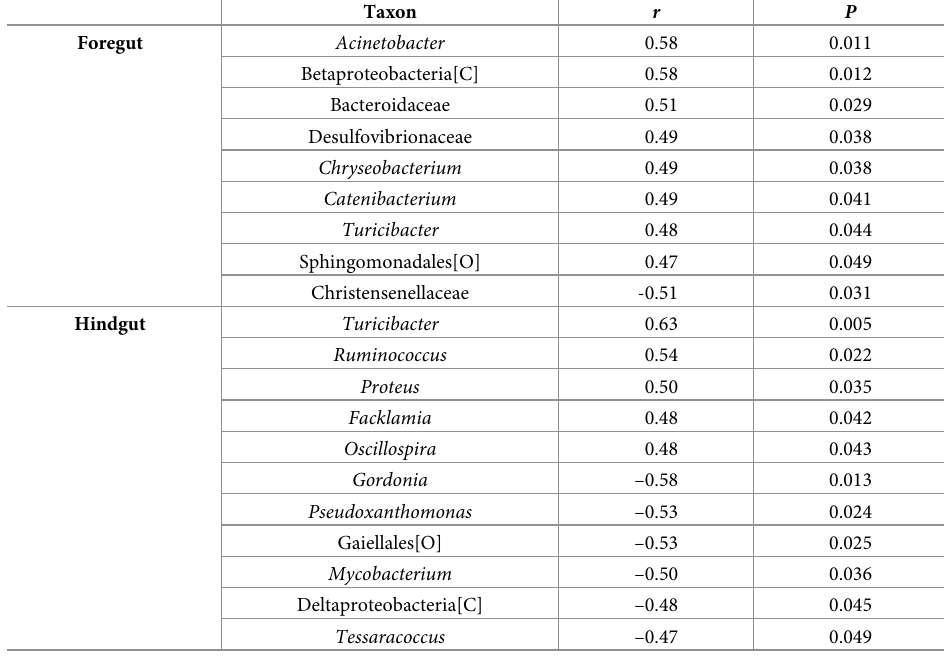
Table 3. Correlation coefficient analysis between tapeworm wet weight and abundance of each bacterium in the intestine of grass carp ( Ctenopharyngodon idella ).